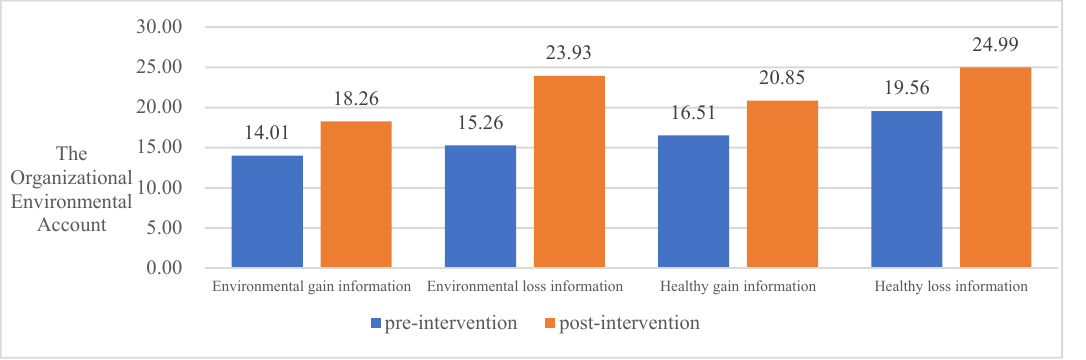
Figure 4. The impact of different information frameworks on the Organizational Environmental Ac- count.